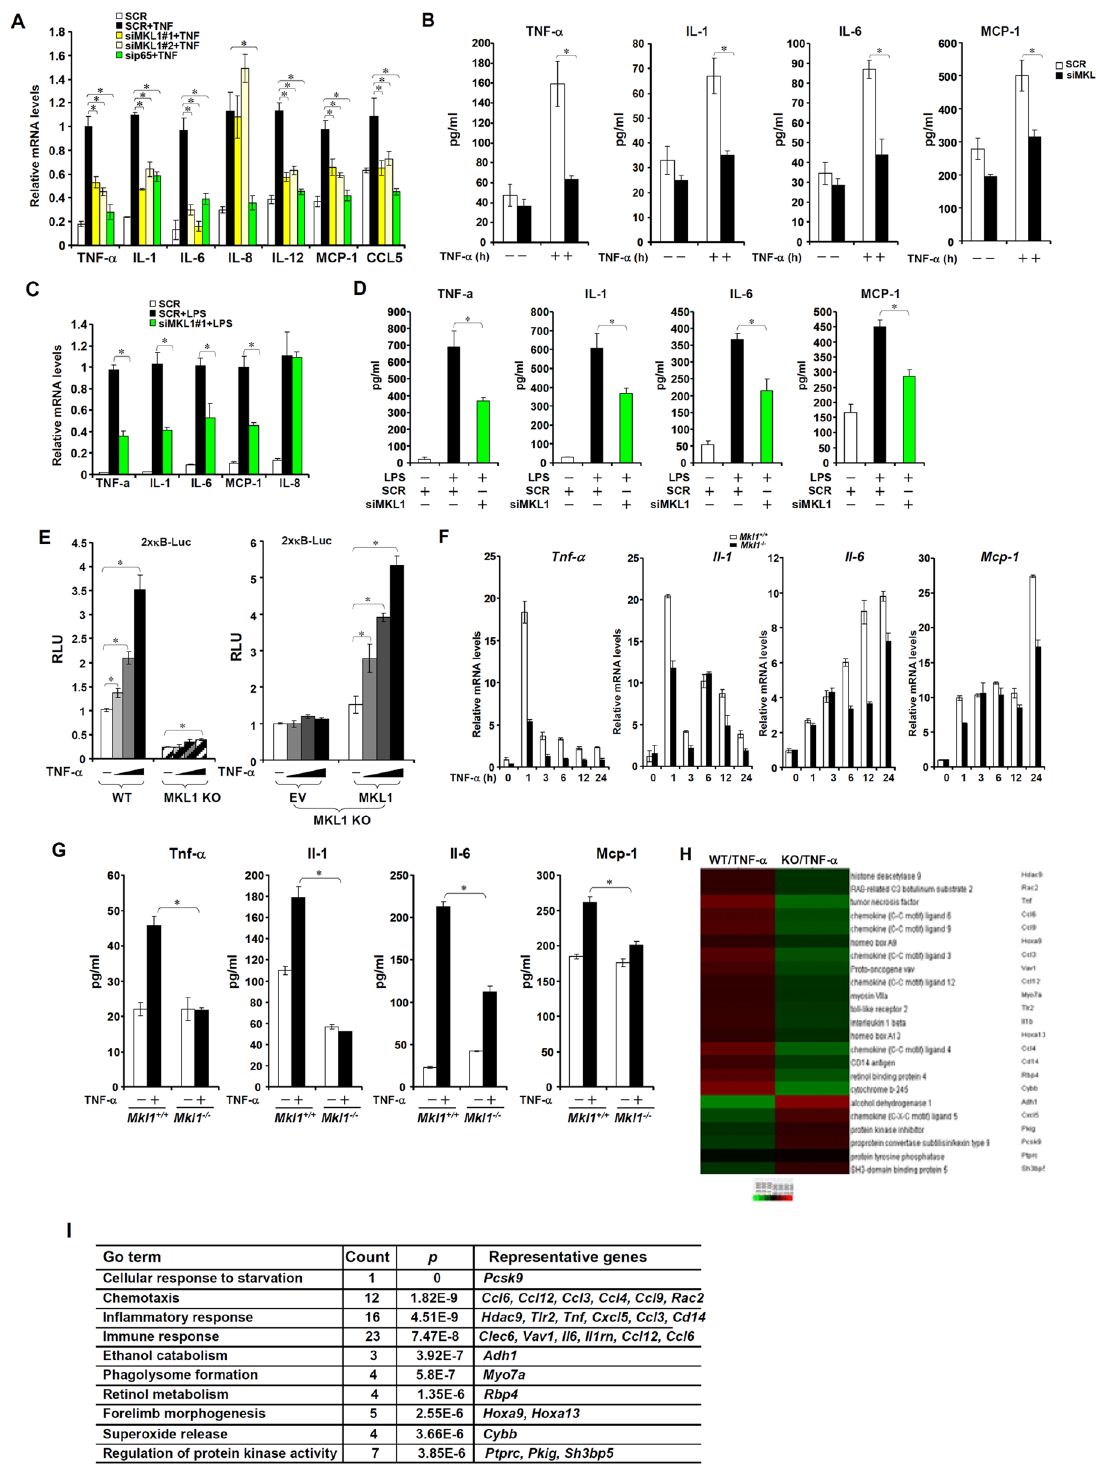
Figure 2. MKL1 deficiency dampens Rel-A/p65 dependent transcription. ( A , B ) THP-1 cells were transfected with indicated siRNAs followed by treatment with TNF- α (10 ng/ml) for 6 hours. mRNA ( A ) and protein ( B ) levels of pro-inflammatory mediators were measured by qPCR and ELISA. ( C , D ) THP-1 cells were transfected with indicated siRNAs followed by treatment with LPS (100 ng/ml) for 6 hours. mRNA ( C ) and protein ( D ) levels of pro-inflammatory mediators were measured by qPCR and ELISA. ( E ) WT or MKL KO MEF cells were transfected with a generic κ B reporter construct followed by treatment with TNF- α (10 ng/ml) for 6 hours. Data are expressed as RLU. ( F – I ) MEF cells were treated with TNF- α (10 ng/ml). mRNA ( F ) and protein ( G ) levels of pro-inflammatory mediators were measured by qPCR and ELISA. ( H ) Heat map and ( I ) Go